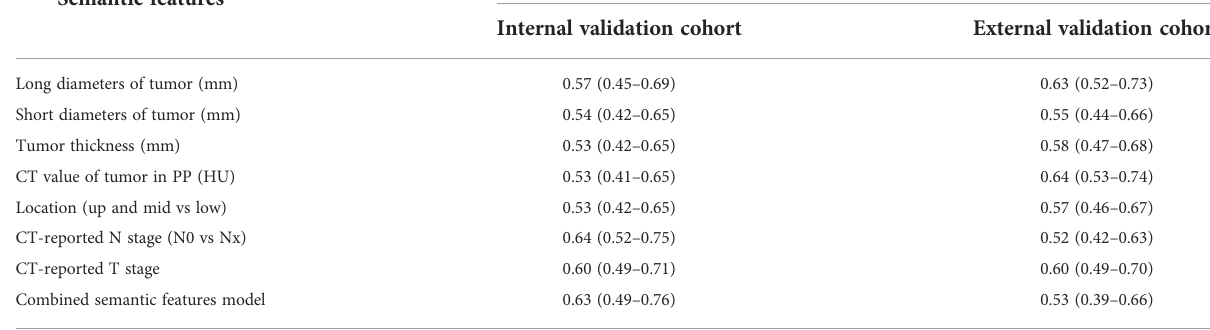
TABLE 2 The performance of CT features extracted by radiologist to predict MMR status